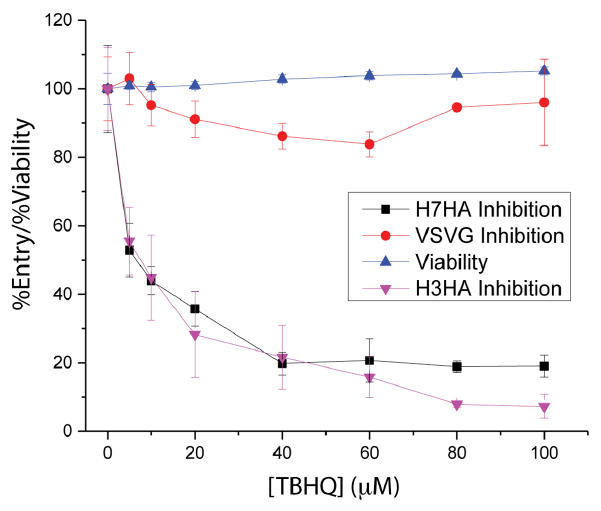
Figure 1. TBHQ inhibits H3 and H7 HA-mediated entry. Each concentration point was performed in